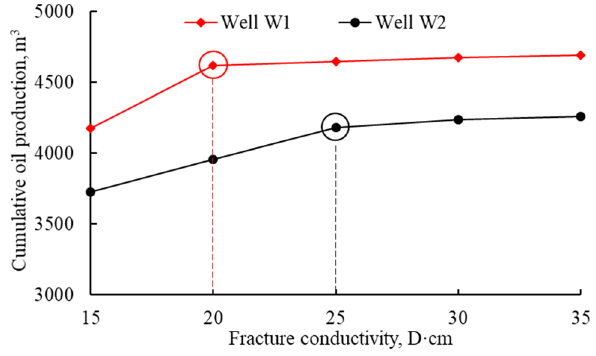
Figure 14. Fracture conductivity optimization results.